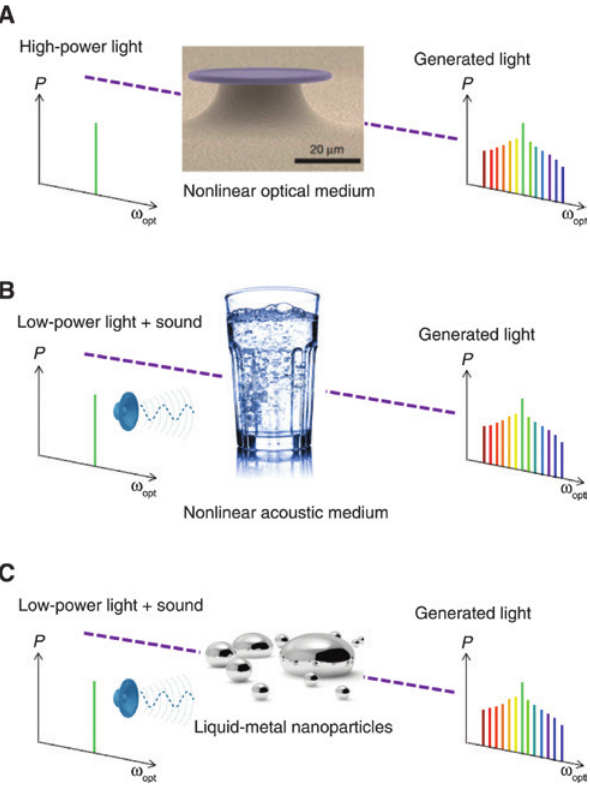
Figure 1: Nonlinear properties of sound are used to generate optical nonlinearities with low-power non-laser